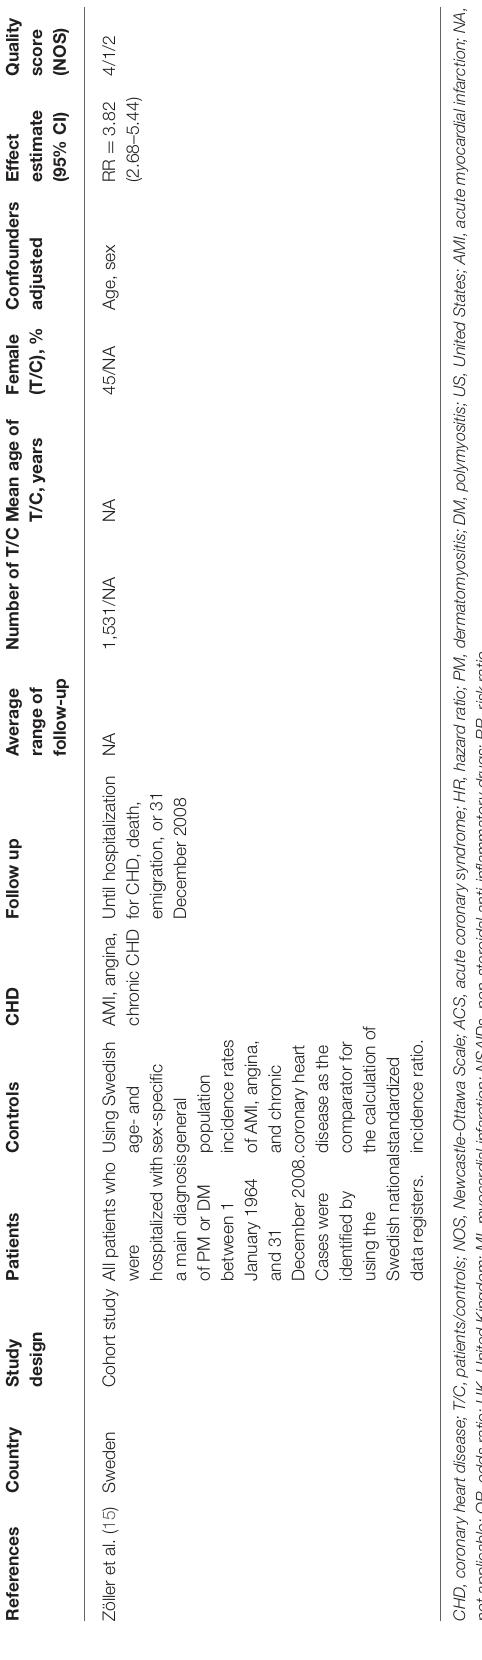
Figure 3C . Heterogeneity was not significant between studies ( I 2 = 29%, P =